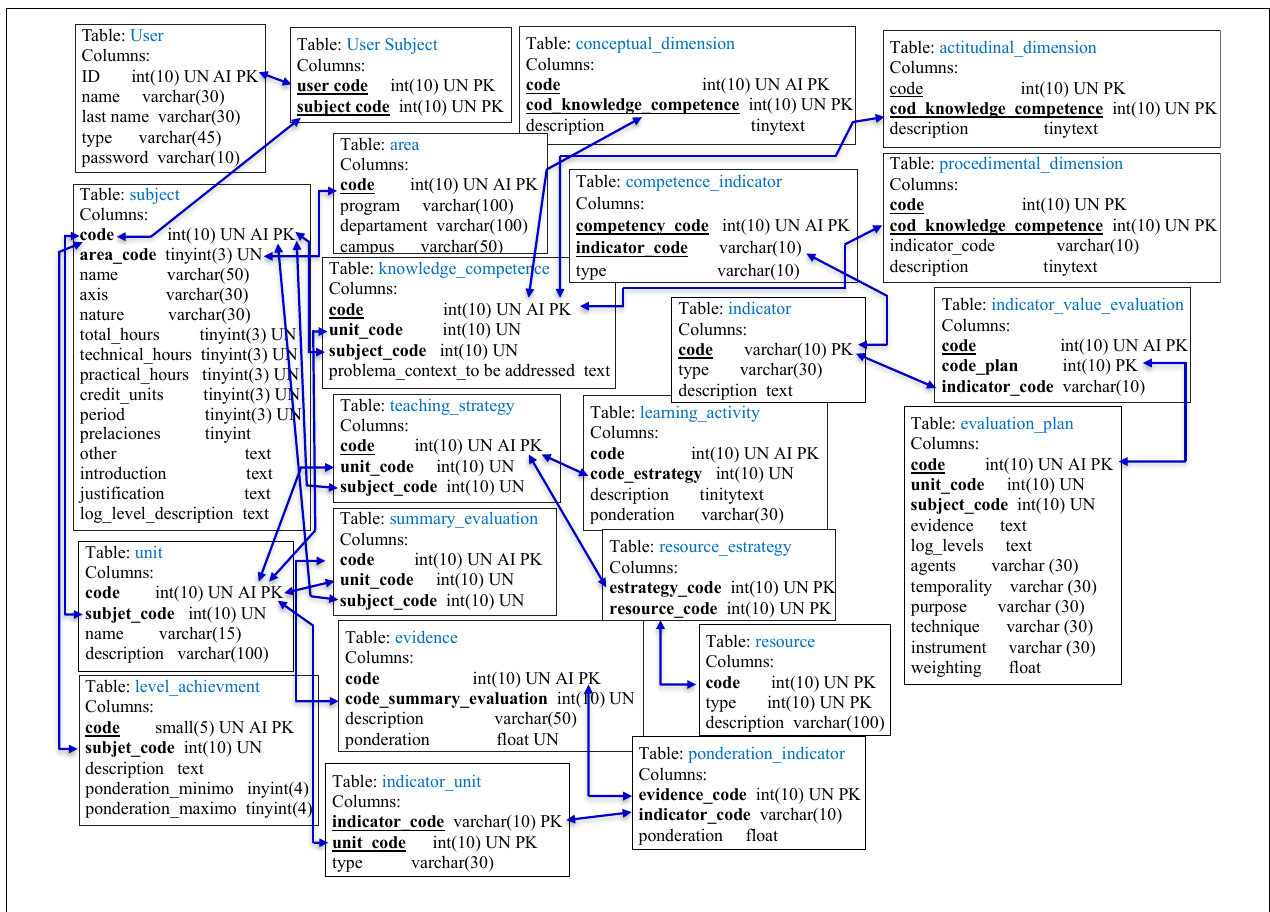
FIGURE 9 | Entity-relationship